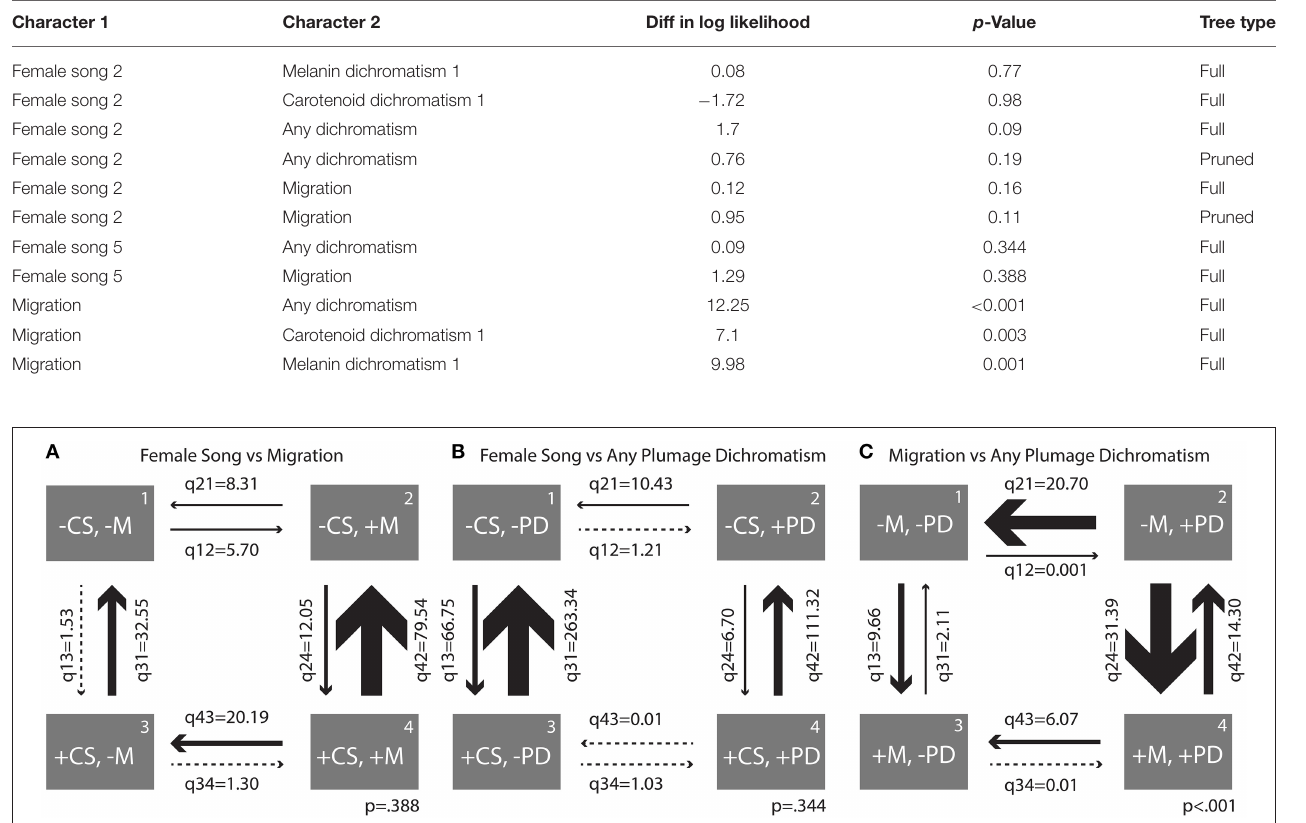
FIGURE 5 | Transition rates derived from correlation analyses between (A) female song 2 and migration, (B) female song 2 and any plumage dichromatism, and (C) migration and any plumage dichromatism. Arrows are scaled to the largest transition rate in each